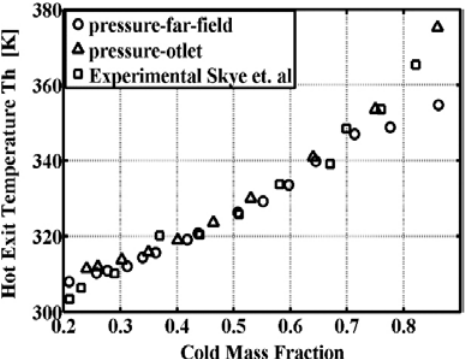
Fig. 8. Experimental hot exit temperature compared with the numerical values of the 3D CFD models applying both types of boundary conditions